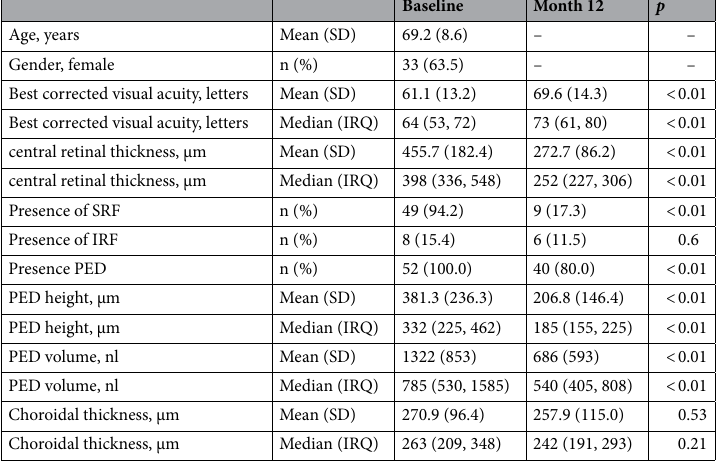
Table 1. Comparison of features between baseline and month 12. SRF sub-retinal fluid; IRF intra-retinal fluid, PED pigment epithelium detachment; p value calculated using chi-square test, t test, Mc-Nemar’s Test or Wilcoxon rank sum